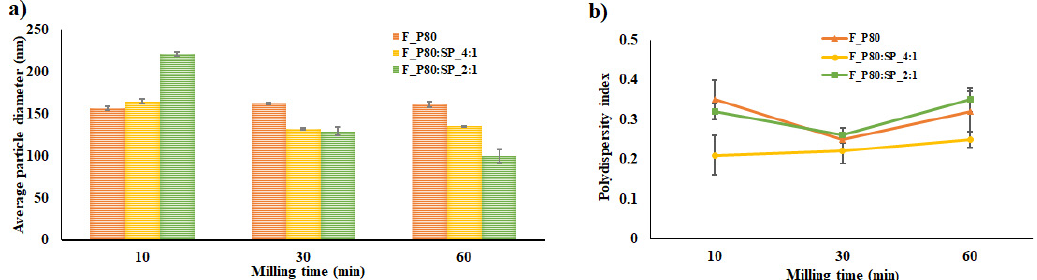
Figure 2: Average particle diameter (a) and polydispersity index (b) of the curcumin dispersions obtained after 10, 30 and 60 minutes of milling Table 1: Screening of potential stabilizers and their concentrations for nanosuspension preparation Stabilizer Stabilizer:CU ratio CU concentration P80 1:1 1:2.5 1:5 1 mg/ml Precipitation within 24 h No Yes Yes SP 1:1 1:2.5 1:5 1 mg/ml Precipitation within 24 h Yes Yes Yes MC 1:1 1:2.5 1:5 1 mg/ml Precipitation within 24 h Yes Yes Yes P80/SP=4:1 1:1 1:2.5 1:5 1 mg/ml Precipitation within 24 h No Yes Yes P80/SP=2:1 1:1 1:2.5 1:5 1 mg/ml No